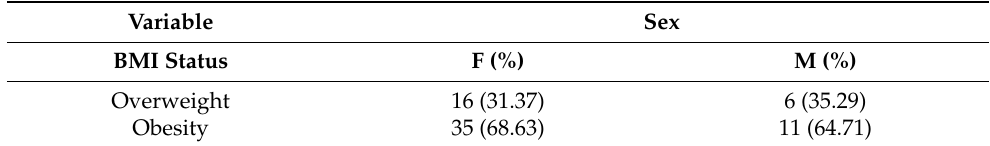
Table 2. Distribution of patients of the whole sample divided by sex (females n = 51, males n = 17) and classified as individuals with overweight or obesity based on their BMI (Kg/h 2 ).